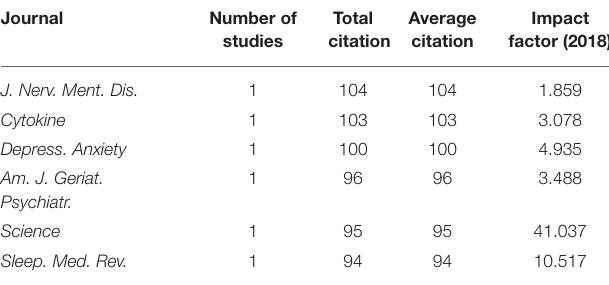
TABLE 2 | Journals of the 100 top-cited studies published.